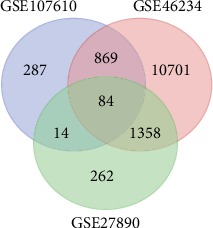
Venn diagram DEGs were selected with P < 0.01 and fold change > 2 among the mRNA expression profiling sets GSE27890, GSE46234, and GSE107610. A total of 84 overlapping genes were obtained.